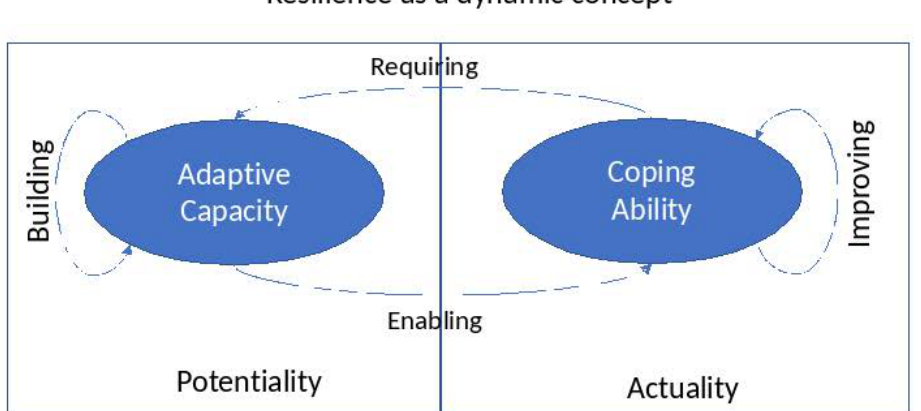
Figure 2. Combining Adaptive Capacity and Coping Ability in a synergistic dynamic dual system.